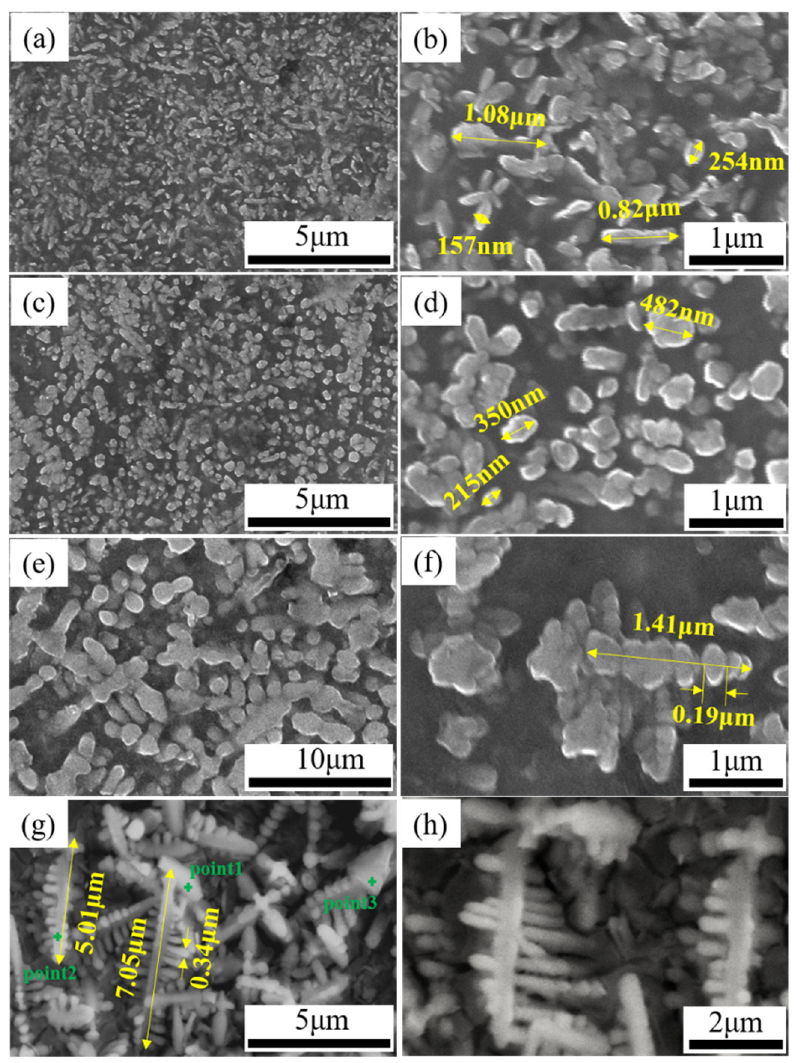
Figure 5. Microscopic morphology of TiC grains with different laser energy densities. ( a , b ) η = 60